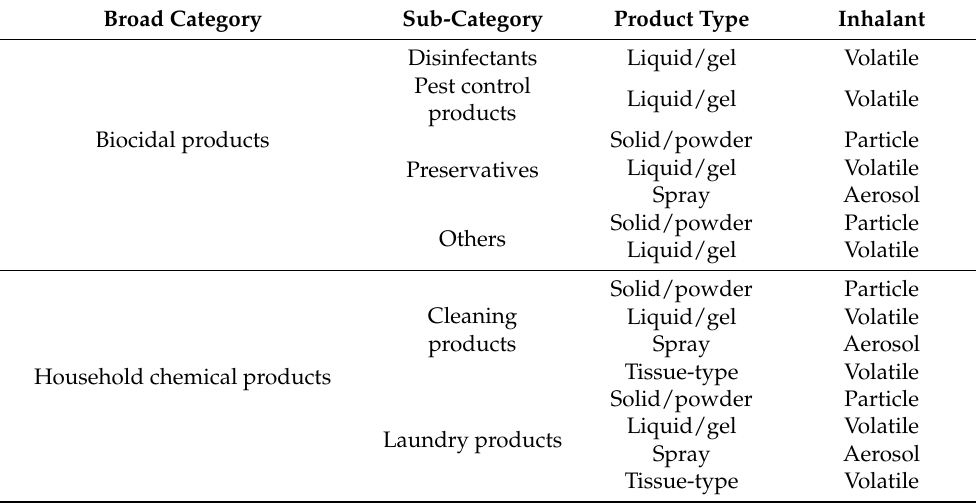
Table 1. Main inhalants having inhalation routes that can be determined by product types and